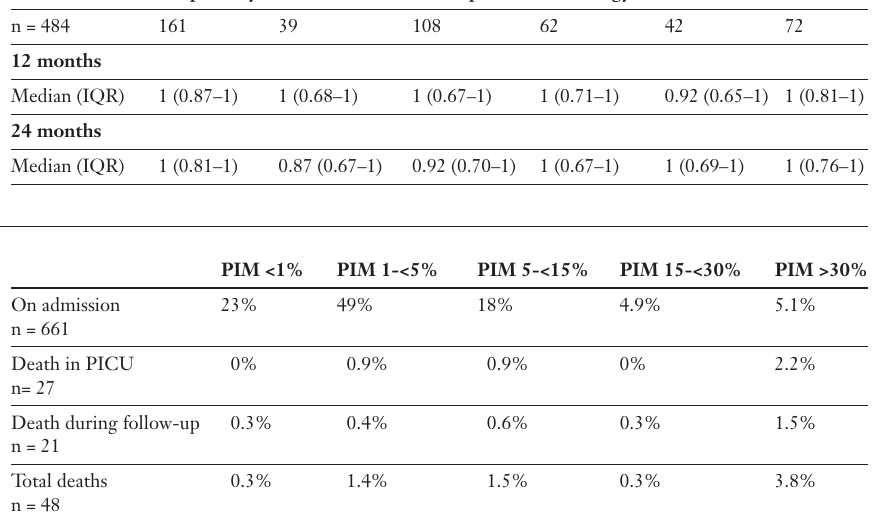
imately 80% of all children enjoy good quality of life after intensive care. Some important and sig- nificant facts regarding PICU outcome need care- ful consideration.